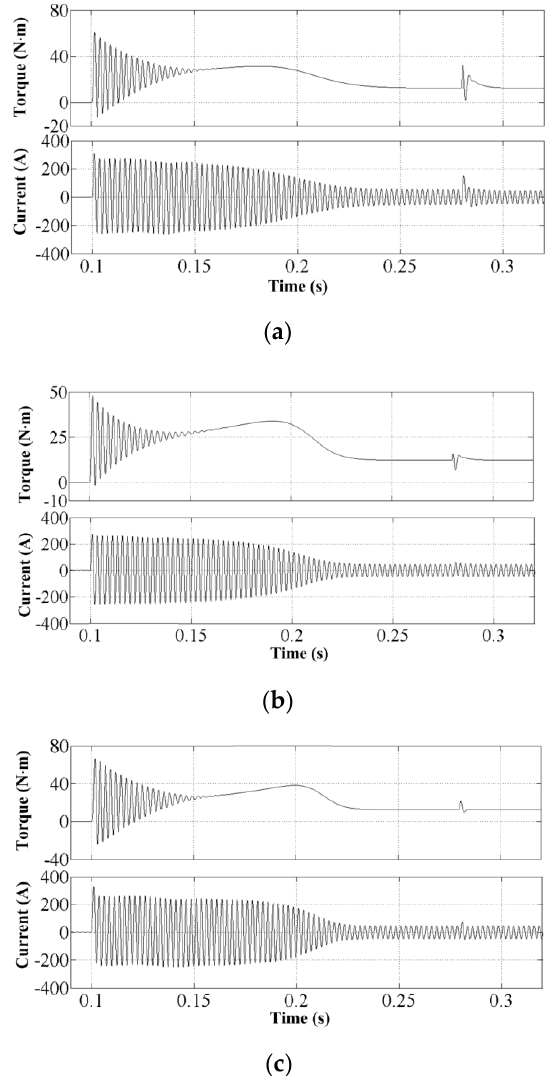
Figure 9. Comparison of torque and current characteristics. ( a ) Voltage reduction starting process ( b ) Series resistance starting process. ( c ) Series inductance starting process.